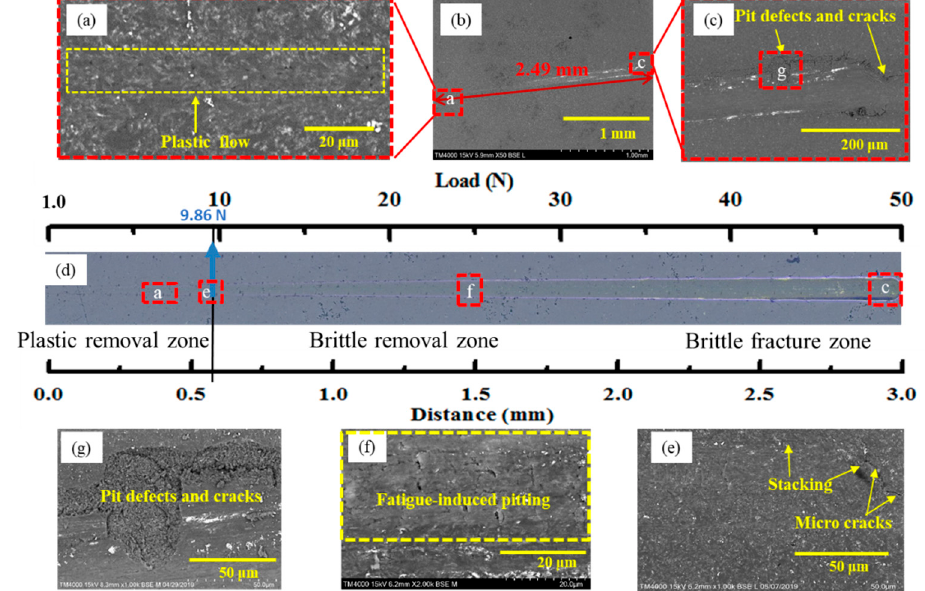
Figure 6. SEM micrographs of surface morphology after scratching under an applied load of 1–50 N: ( a ) full view; ( b ) ductile regime; ( c ) brittle–ductile coexisting stage; ( d ) brittle fracture regime; ( e ) morphology of pit defects; ( f ) morphology of fatigue-induced pitting; ( g ) morphology of pit defects and cracks.